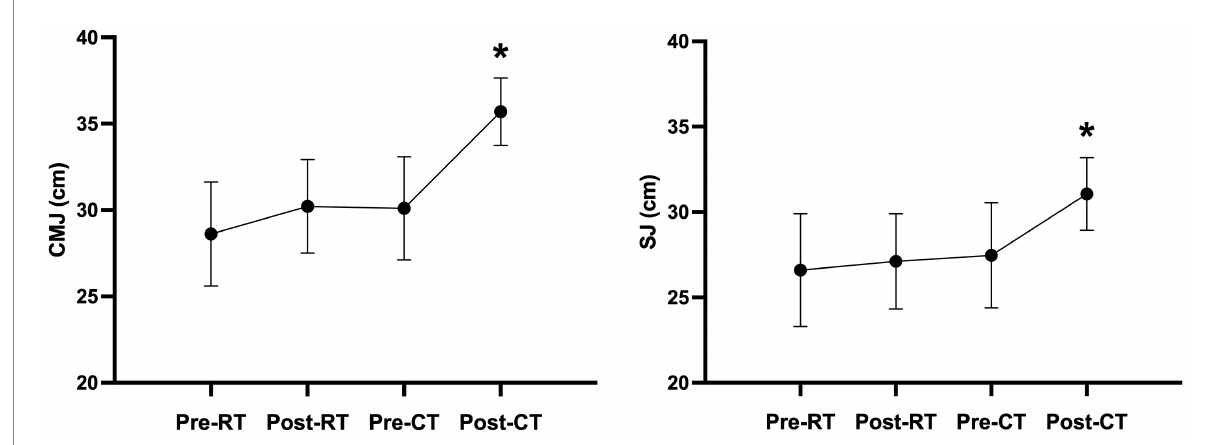
FIGURE 1 The assessment results of CMJ and SJ after CT intervention compared to all pre- and post-intervention. *Statistically significant difference as compared to all the other pre- and post-interventions, p < 0.05.